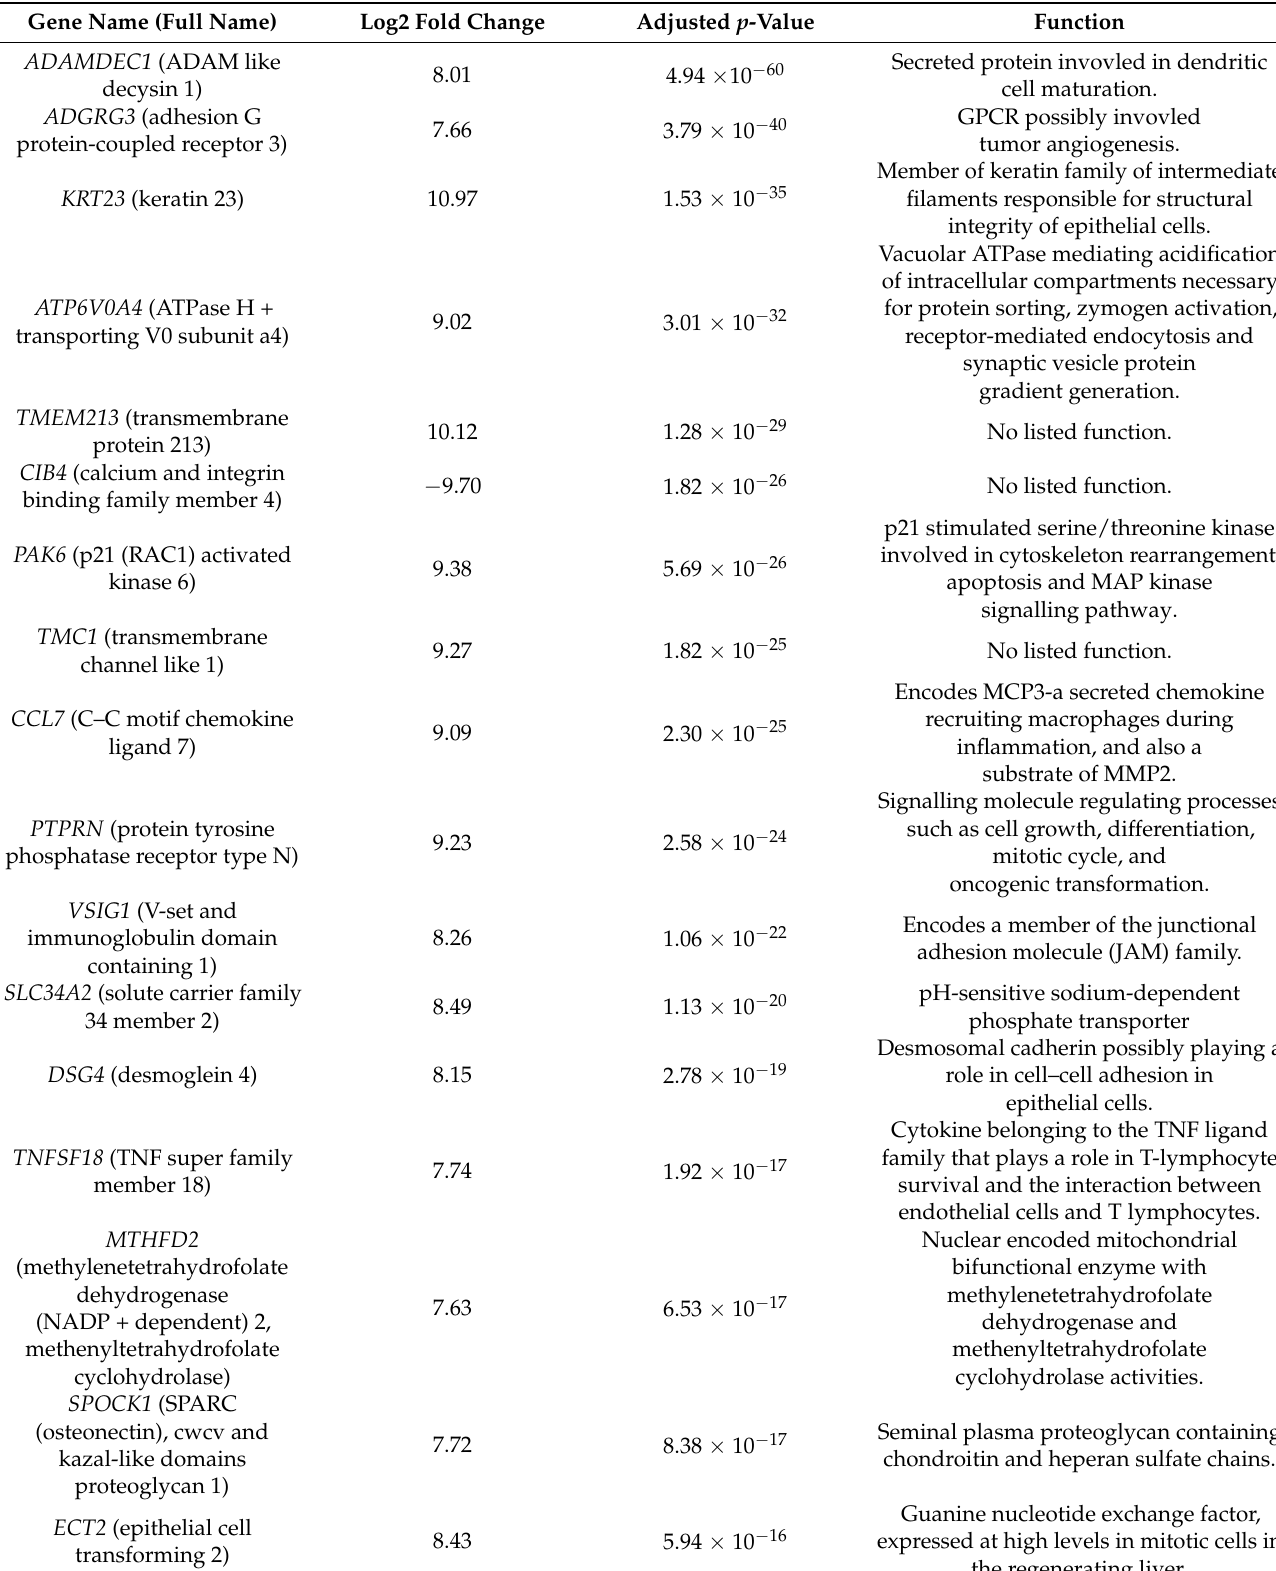
Table 3. Top 20 differentially expressed genes in guinea